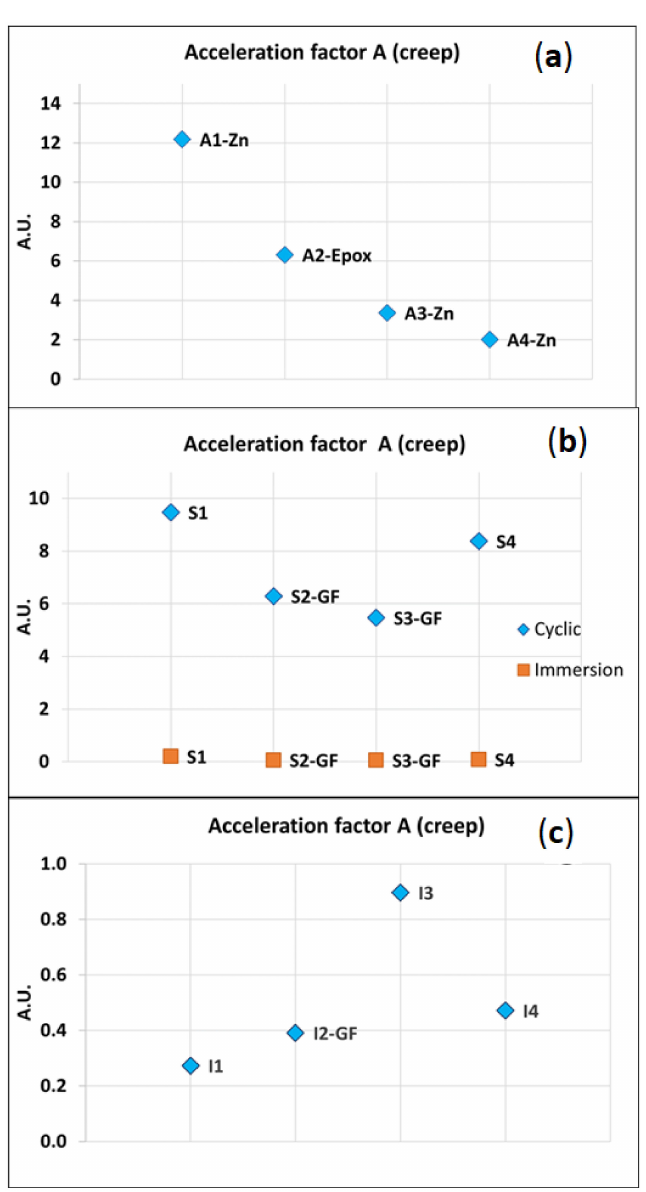
Figure 11. Acceleration factors for the coating systems for the atmospheric zone ( a ), splash zone ( b ), and submerged zone ( c